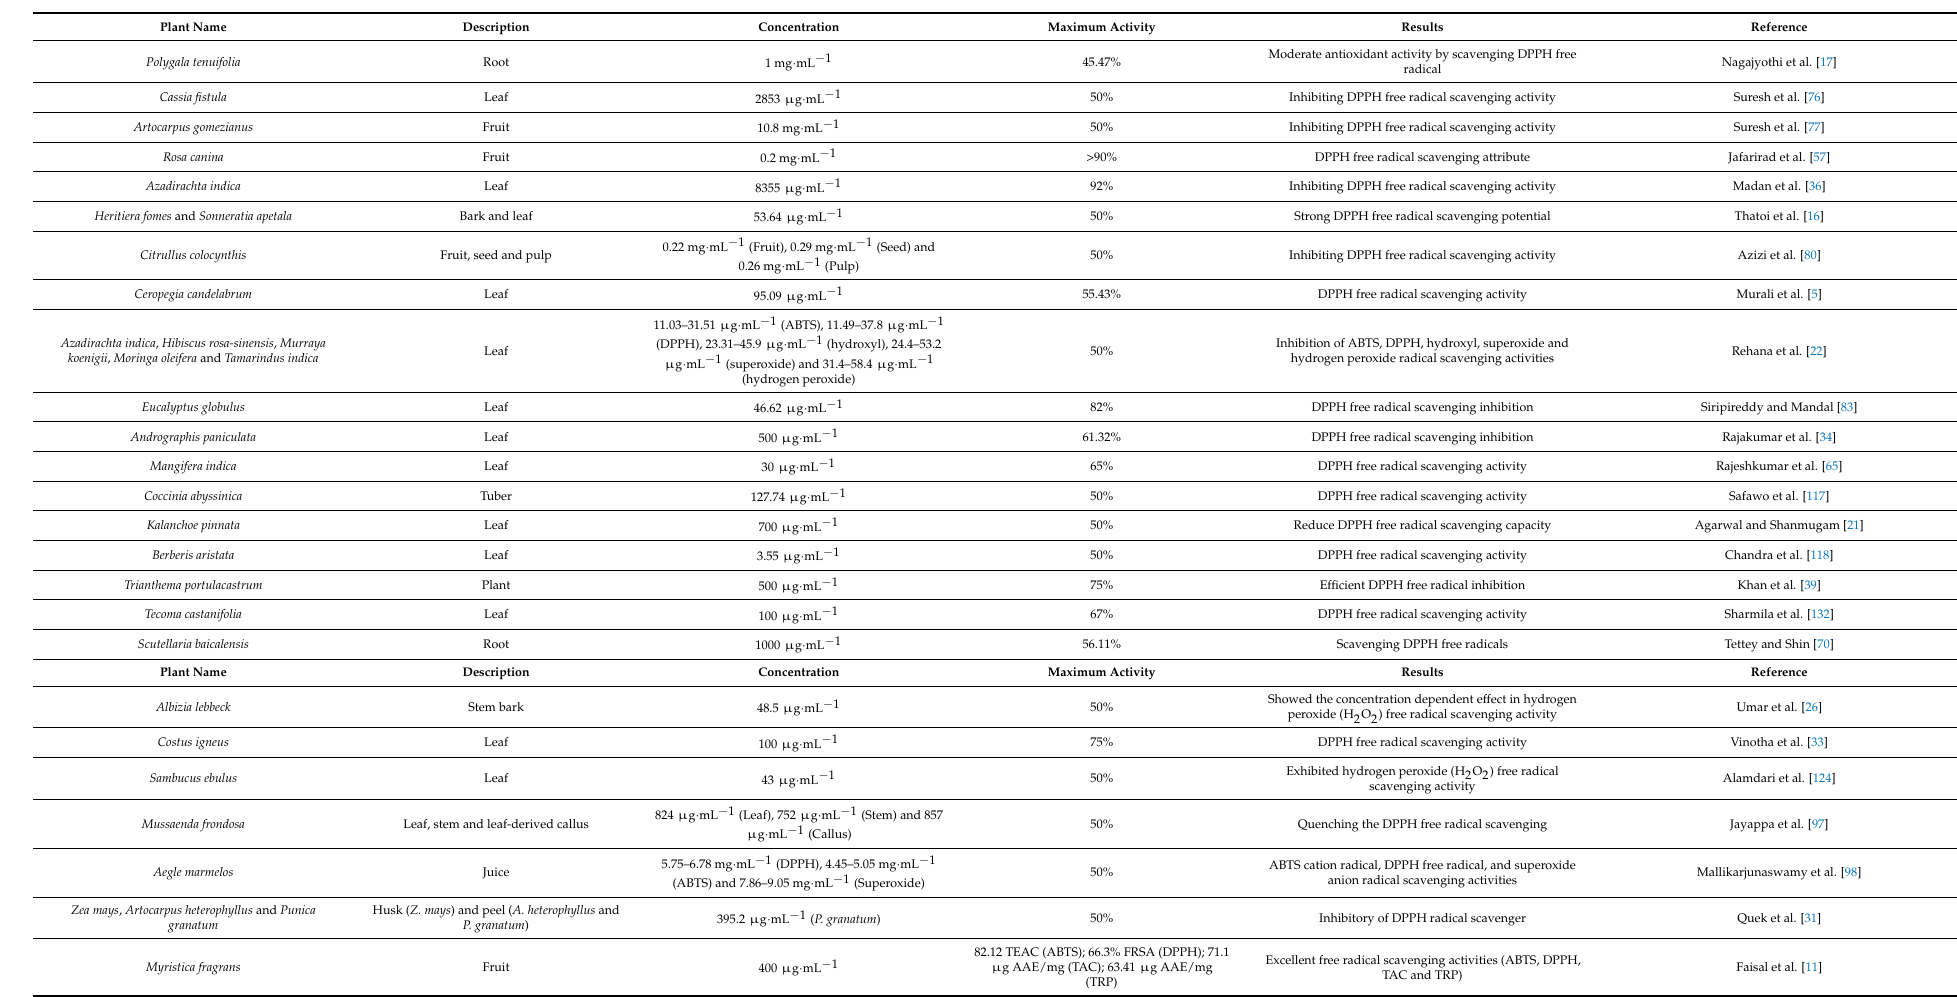
Table 3. Antioxidant activity of plant-mediated zinc oxide